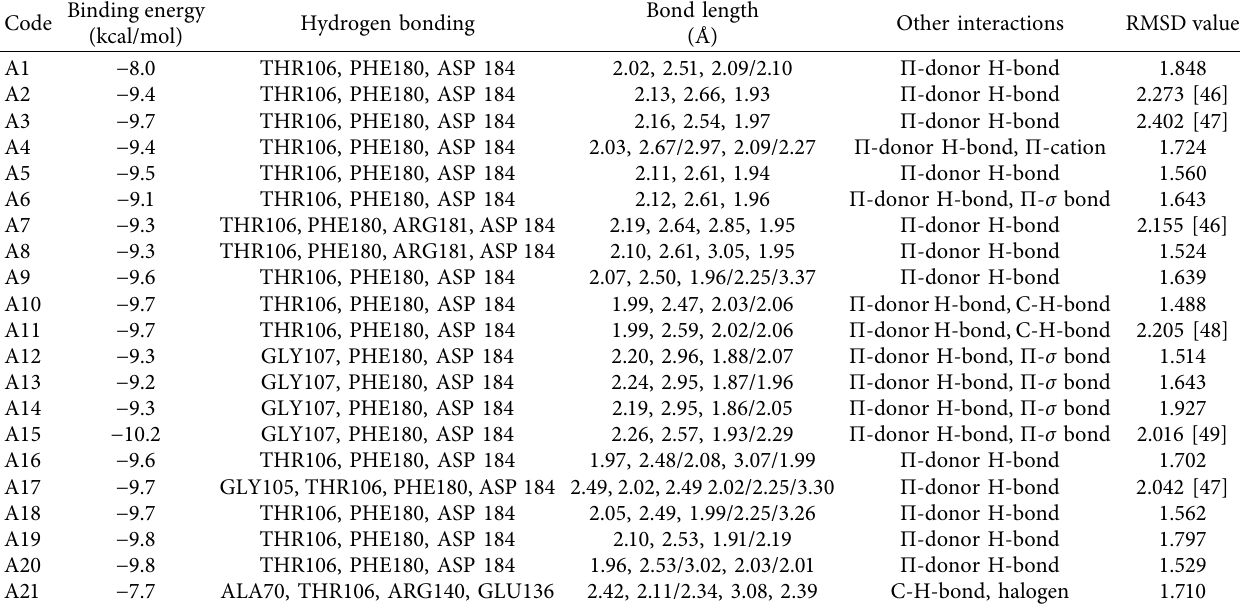
Table 3: Binding energy hydrogen bonding, bond length, other interaction, and RMSD value of ligands.